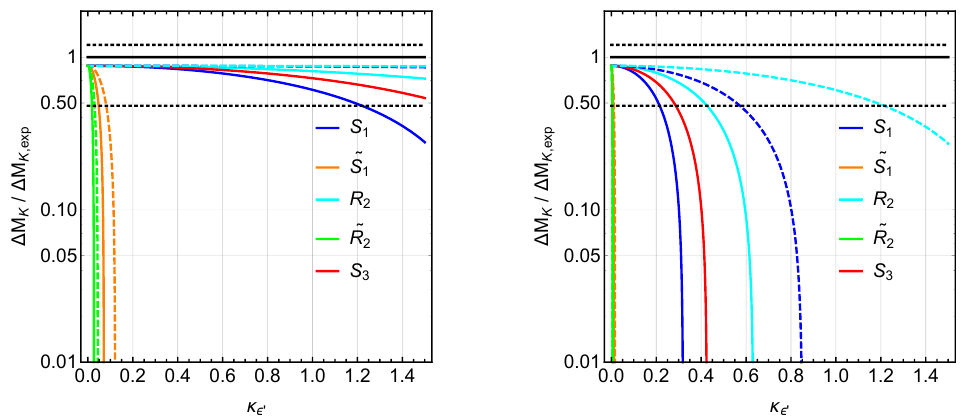
Figure 8. The dependence of the short-distance part of (cid:1) M K = (cid:1) M K; exp on (cid:20) " 0 for M LQ = 2 TeV [left] and M LQ = 20 TeV [right]. The dashed lines show the e(cid:11)ect of box-diagram contribu- tions in " 0 =" for (cid:6) 11 2 [0 : 0 ; 1 : 0]. Further shown are the experimental measurement [black solid] L;R and the SM prediction [black